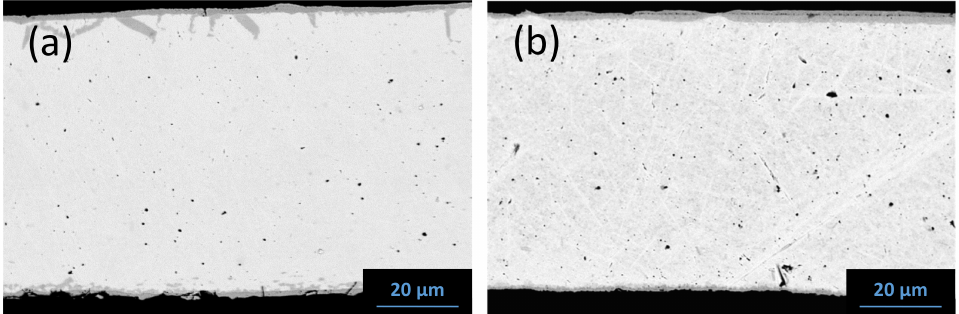
Figure 15. Initial state of the liner material in the sandwich cladding made of ( a ) niobium and ( b ) tantalum after the